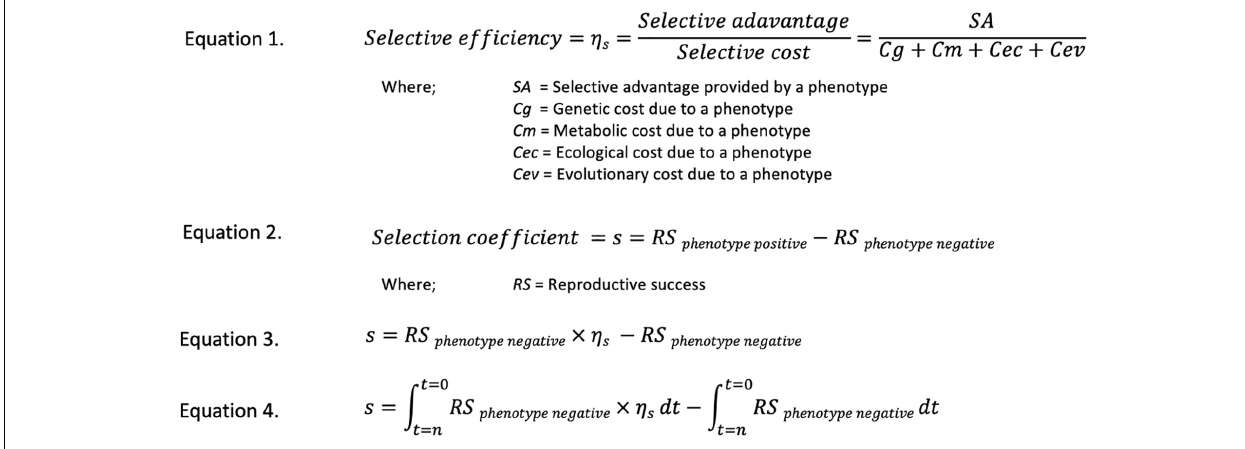
FIGURE 1 | An explanation of the Selective efficiency concept and how it relates to the selection coefficient s using hypothetical equations. Selective efficiency provides a benefit/cost assessment of a selective phenotype and so expands the utility of the selective coefficient s as shown in these equations. Equation 1 shows the components of selective efficiency. Equation 2 shows the components of the selection coefficient s. Equation 3 shows the amalgamation of selective efficiency as represented by Equation 1, into Equation 2. Equation 4 shows the integration of Equation 3 with respect to time, from time 0 to time n, to account for possible time variant changes in selective efficiency. While not used in this work, it should be pointed out that the various factors involved in the selective efficiency concept may be determined experimentally. In essence, this may be accomplished in a microbial model, consisting of two mutants, one with the genes responsible for the phenotype in question removed and another with those genes still present but prevented from expression. These mutants are grown in parallel with both phenotype expressing and wild type organisms in the presence and absence of stressors to which the phenotype is relevant. The relevant values may then be determined by comparing the growth rates of various